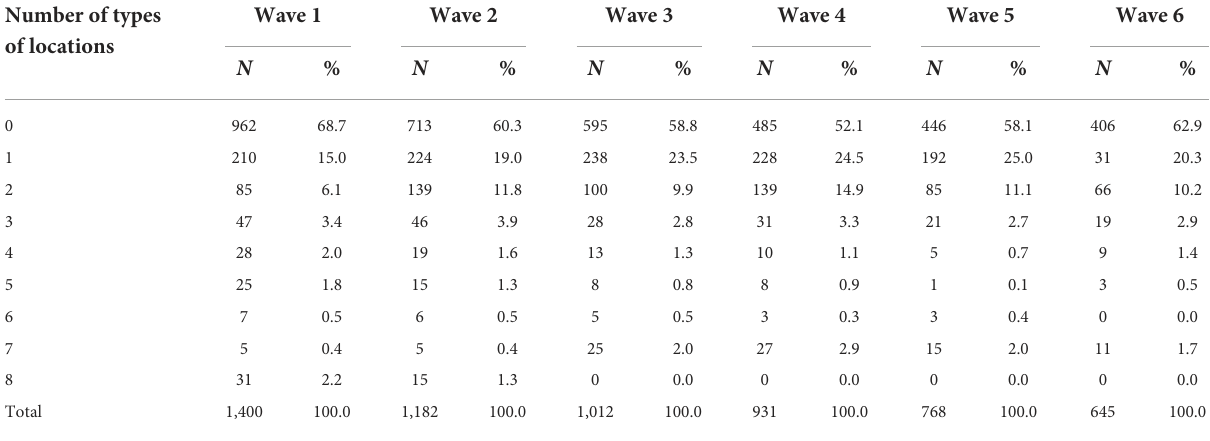
TABLE 2 Number of types of crowded locations visited—or was intended/planned to visit—during the last 7 days, for each wave of data collections. Number of types of